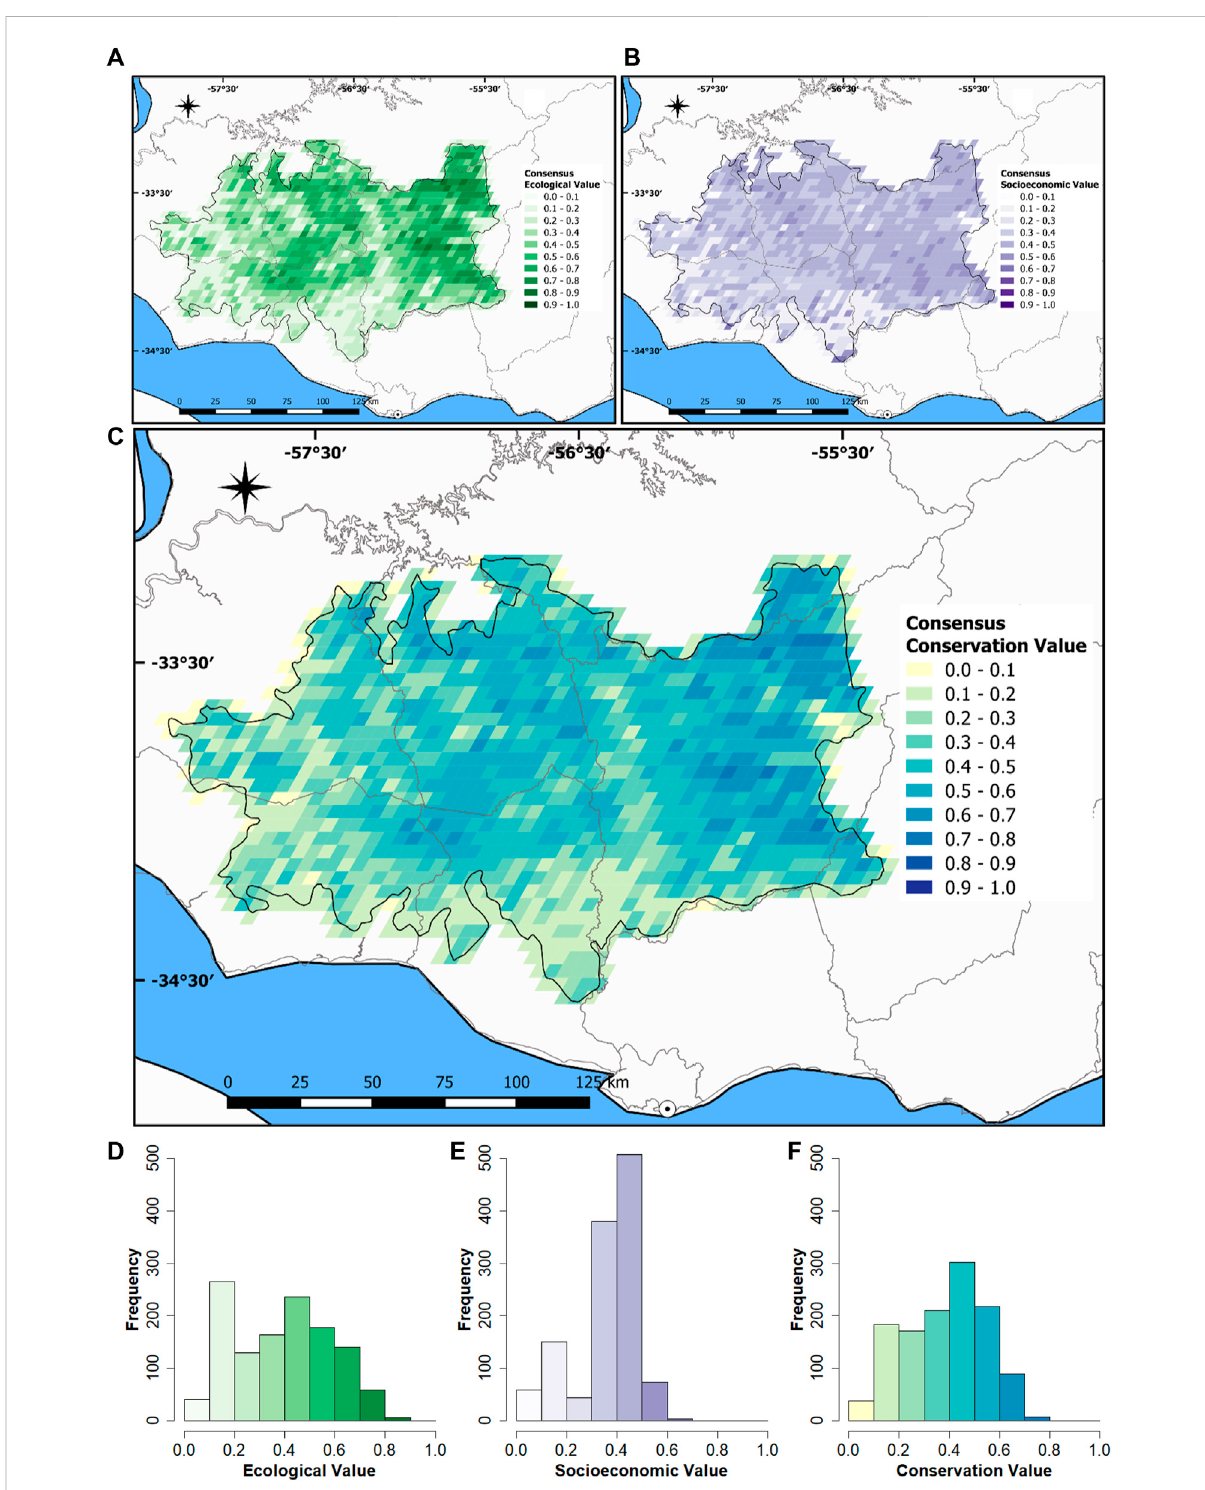
FIGURE 7 Consensus maps and histograms of Ecological Value (EV) (A and D) , Socio-economic Value (SV) (B and E) and Grasslands ’ Conservation Value (GCV) (C and F)